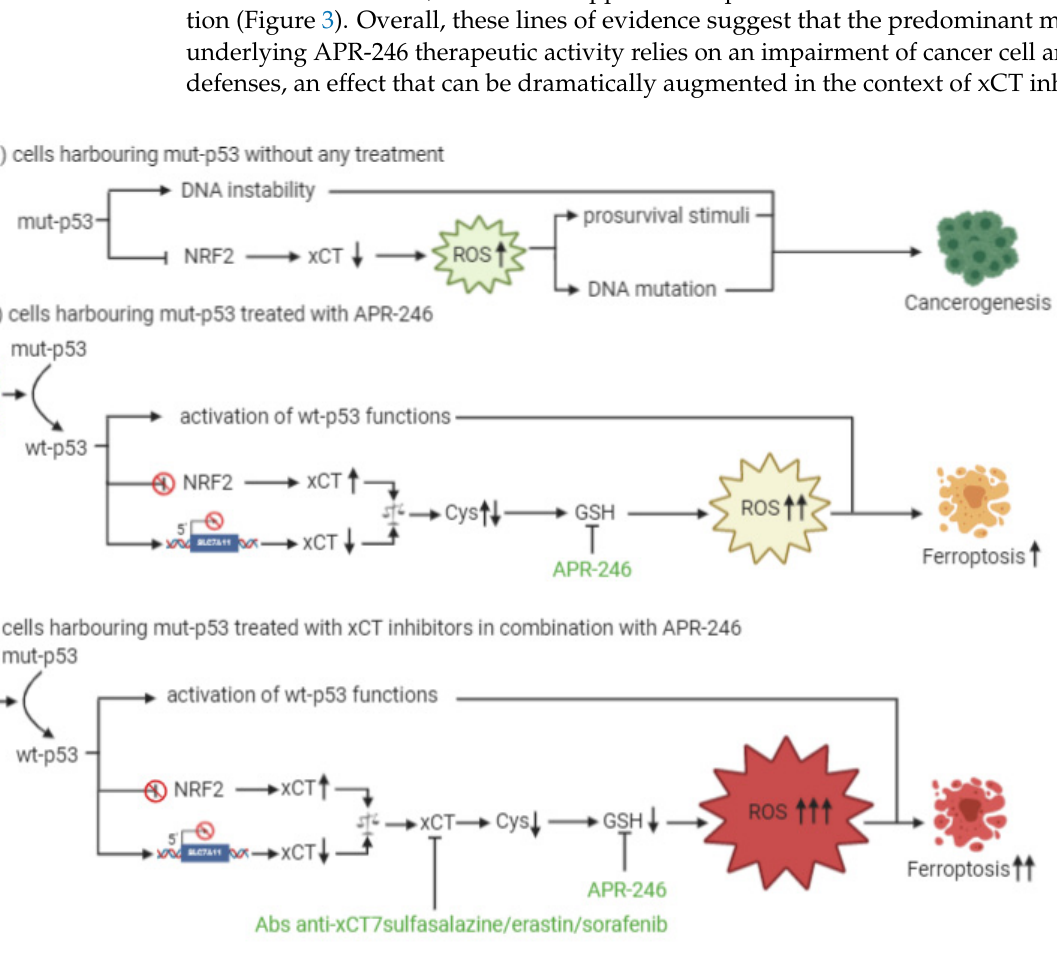
Figure 3. A schematic explanation of the rationale for combined treatment. ( a ) The effects of mut-p53 on cell cycle and redox balance. mut-p53 favors cancerogenesis by inhibiting NRF2-dependent xCT transcription and consequently slightly increasing the amount of intracellular ROS, which stimulates the cell to proliferate. ( b ) The effects of APR-246 treatment. mut-p53 is converted to its active form (wt-p53), leading to pro-apoptotic functions and the selective induction of ROS increase via GSH depletion, although the mut-p53-dependent inhibition of xCT expression is lost. This causes cells to undergo ferroptosis. ( c ) The effects of the combined treatment. APR-246-dependent GSH depletion together with xCT inhibition sharply decrease GSH levels, inducing high ROS levels that overwhelm the antioxidant capacity of the cell and finally lead to ferroptotic death. This figure was created with BioRender.com.